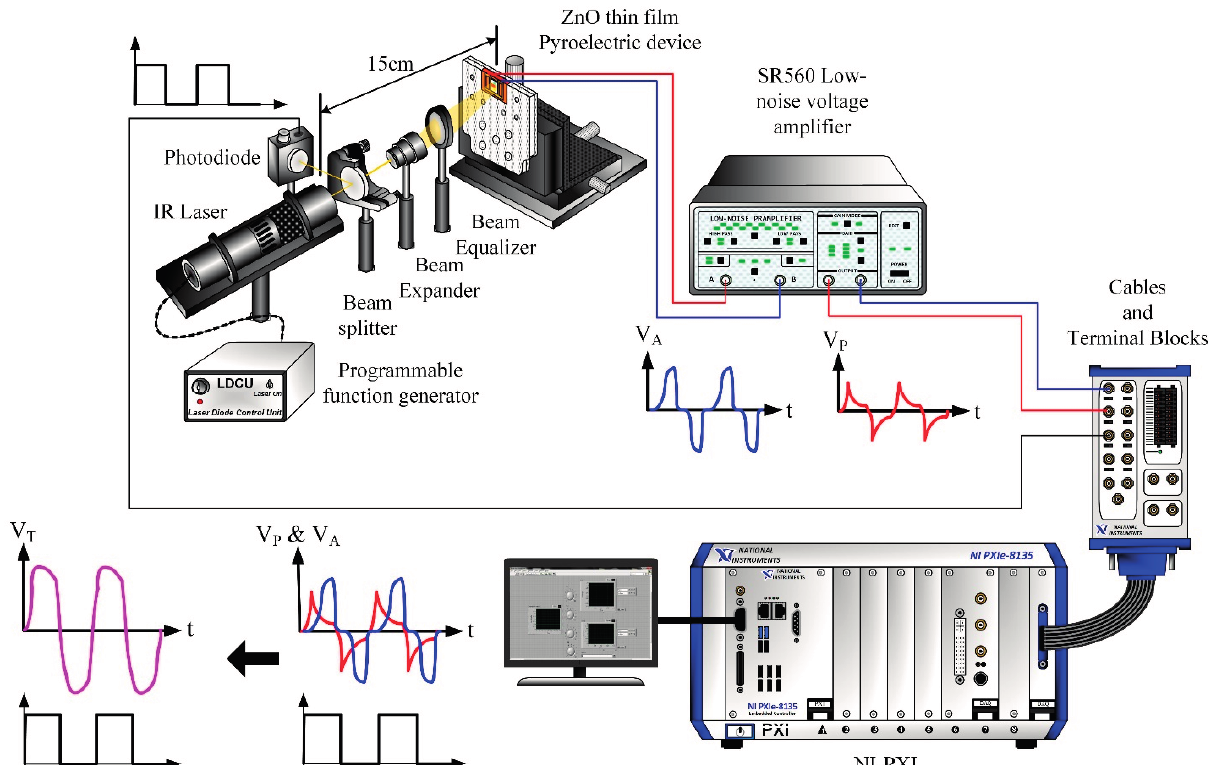
Figure 7. Schematic diagram of voltage responsivity measurement